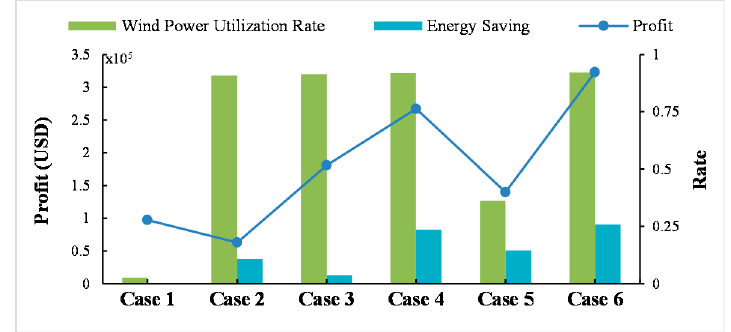
Figure 13. Performance of the dispatch schemes in Case 1–6.